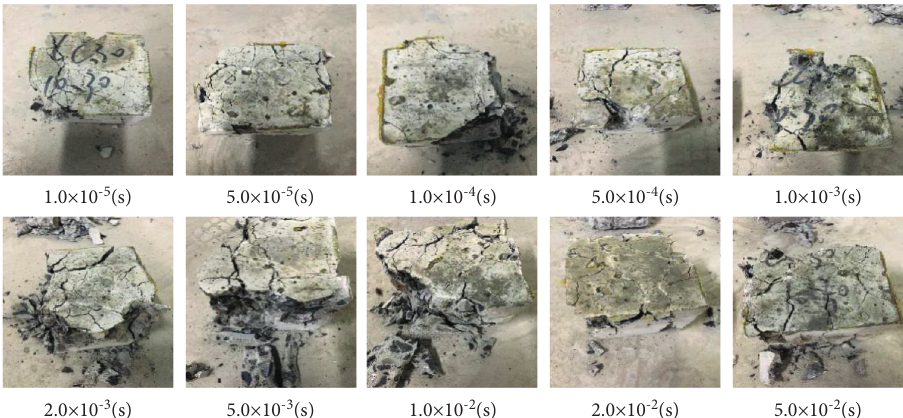
Figure 2: Failure modes of lightweight aggregate concrete under uniaxial compression at different strain